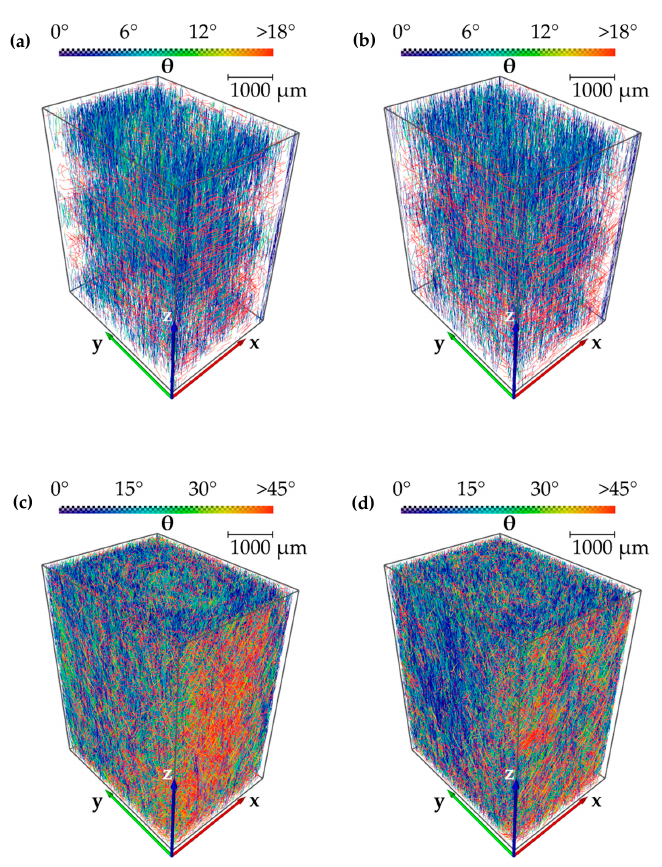
Figure 13. Results of fiber tracing from X-ray microtomography analysis and representation of angle Θ (theta) by a color scale in lower-resolution volumes (Nikon XT H 160) of configuration 1 ( a ) and 8 ( b ) and in high-resolution volumes (Zeiss Xradia Versa 520) of configuration 1 ( c ) and 8 ( d ).